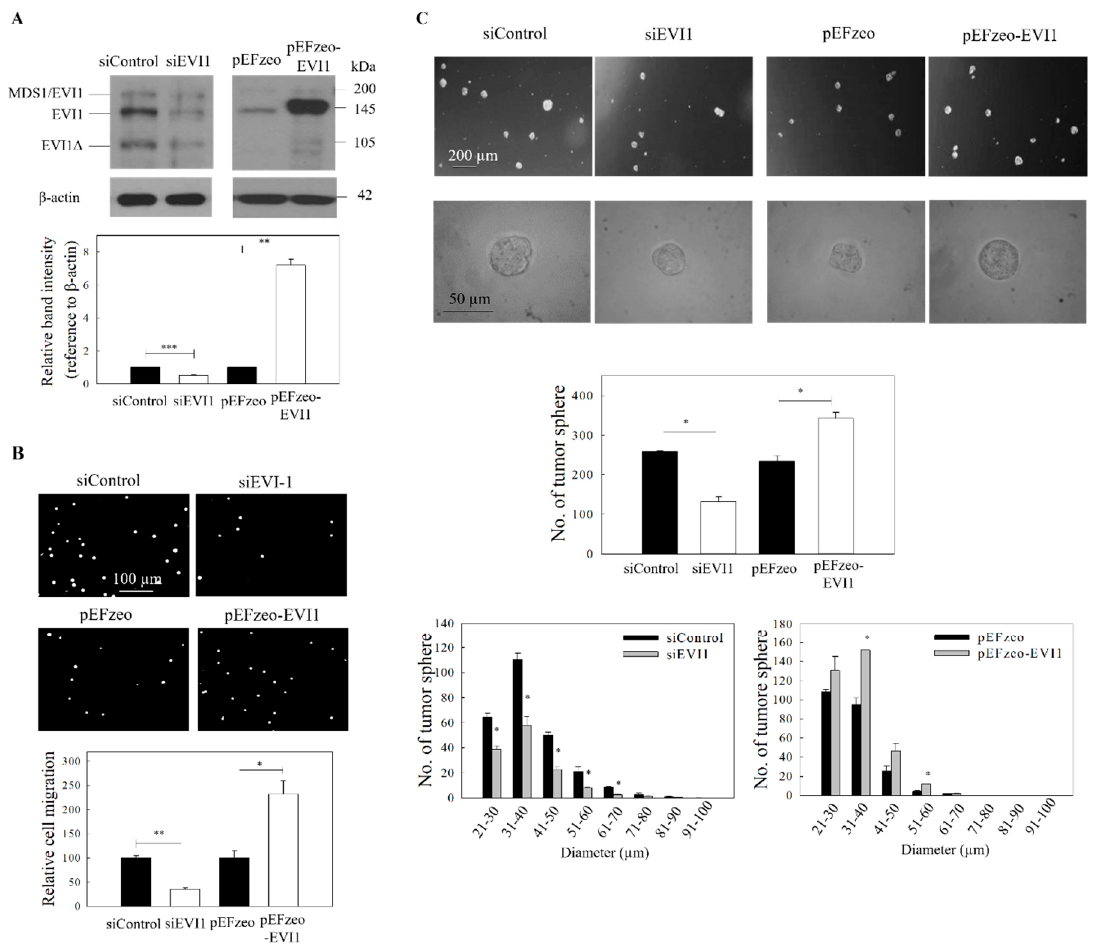
Figure 2. ICG-001 inhibits the migration and tumor sphere formation of C666-1 cells. Cells were transfected with either EVI1 siRNA pool (siEVI1) or expression plasmid (pEFzeo-EVI1). Negative control siRNA (siControl) or pEFzeo vector without the target insert were used as controls. ( A ) The transfection efficiency was assessed by Western blotting analysis. Representative images are presented in the upper panel, and signal intensities were determined by quantitative densitometry and expressed as fold change of EVI1 normalized to β -actin in the lower panel. ( B ) Migration of the transfected cells was assessed by transwell migration assay. Upper panel: images of the migrated cells. Lower panel: quantitative measurement of the migrated cells. ( C ) Tumor sphere formation assay. The transfected cells were harvested and subjected to tumor spheroid formation assay. Representative bright-field images (upper panel), total number (middle panel) and size distribution of tumor spheres (lower panel) are presented. At least three independent experiments were carried out. * p < 0.05; ** p < 0.01; *** p < 0.001 compared with the corresponding control.